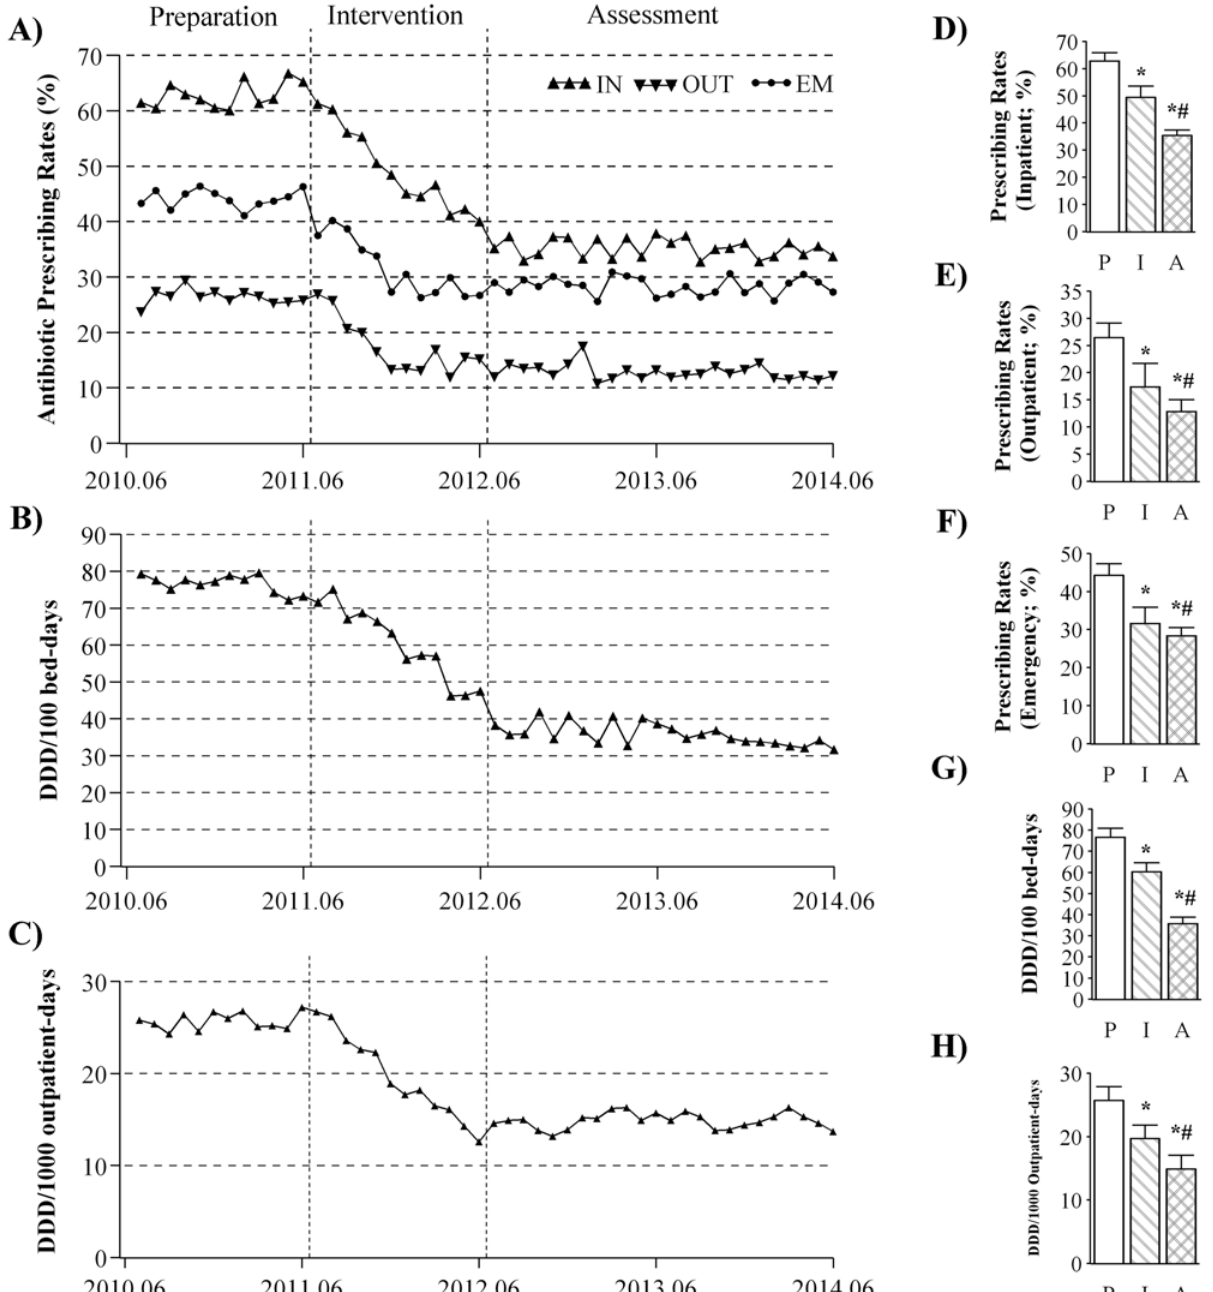
Fig 1. Changes in antibiotic prescribing rates and intensity of antibiotic consumption. Time series of average monthly value of the antibiotic prescribing rates (A) were plotted for inpatient (IN), outpatient (OUT), and emergency (EM) settings. The data on intensity of antibiotic consumption were plotted for the inpatient (B) and outpatient settings (C). Cross-sectional analyses were conducted by comparing the average yearly data on antibiotic prescribing rates in inpatient (D), outpatient (E) and emergency (F) settings as well as the intensity of consumption in the inpatient (G) and outpatient (H) settings. P: preparation; I: intervention; A: assessment; * significant difference in intervention/assessment vs. preparation; # significant difference in assessment vs. intervention.